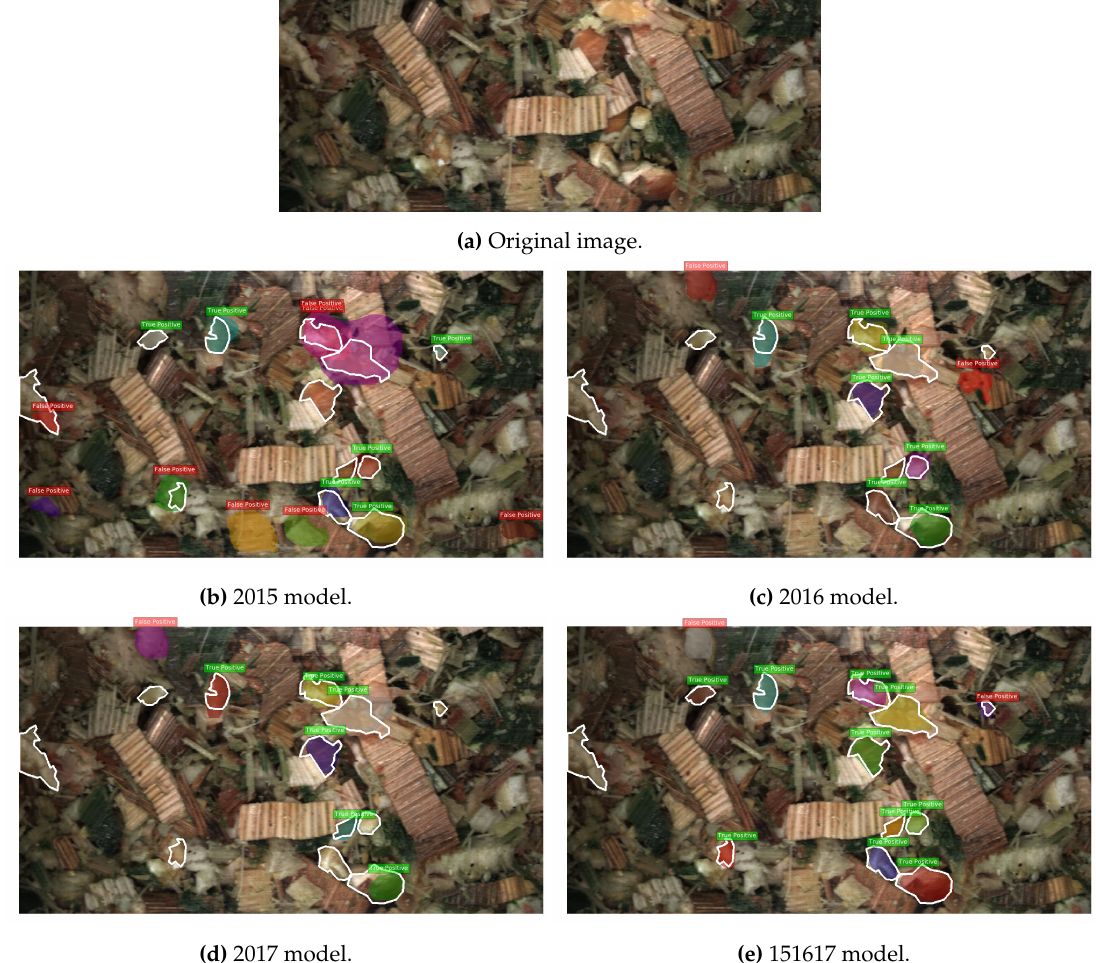
Figure 8. Model predictions on a test image from 2016. Ground truth annotations are shown as a white outline around the kernel fragment. The colour in the text box indicate true positive ( green ) and false positive ( red ). True positives and false positives evaluated at an IoU threshold of 0.5. The individual colour for each prediction indicate separate instances of